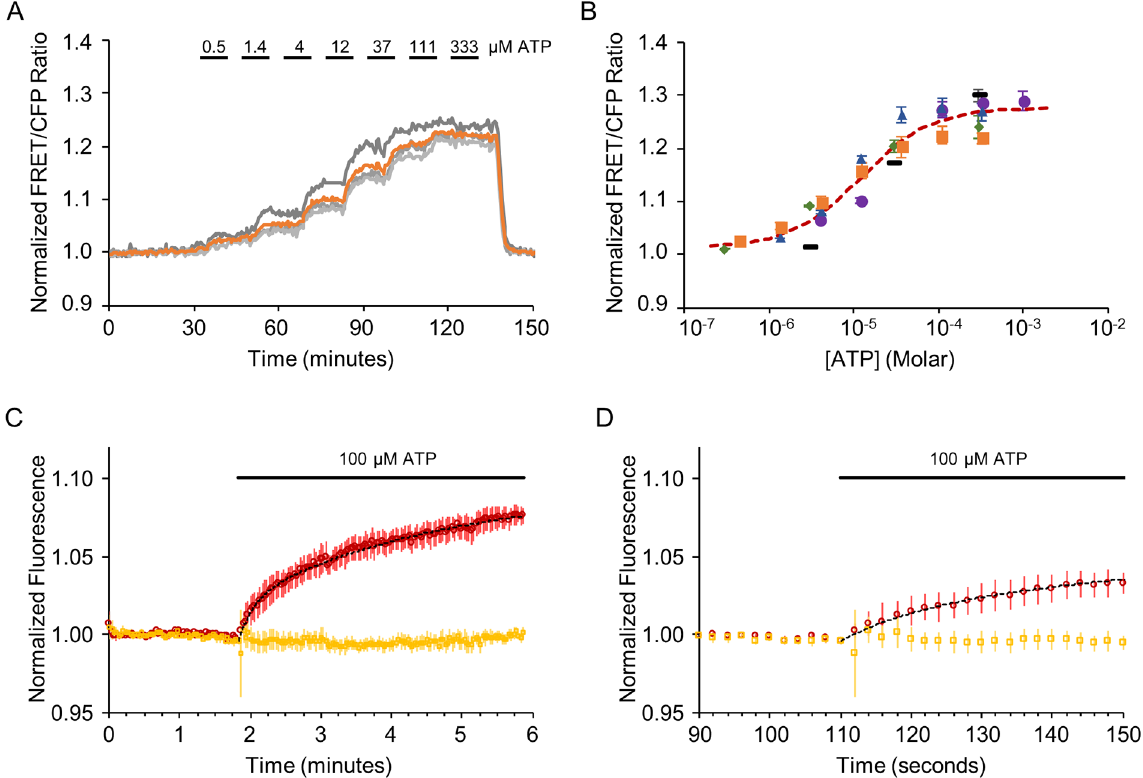
Fig 3. Characterization of ATP affinity and response kinetics. ecATeam3.10 exhibits a concentration-dependent changein FRET/CFP ratio signal.Live Neuro2Acells expressingecAT3.10 were imagedat room temperatureunder continuous perfusion, duringwhich increasing concentrations of extracellular ATP were washed in a stepwise fashion. (A) A representative time course from one experiment with four cells. Each grey trace represents the responsefrom an individual cell in which the regions of interest were drawn aroundthe membrane. The orangetrace is the mean response. (B) Summary of ATP dose-response data from five independent experiments, each representedits own symbols. The orangesquaresrepresent data from (A), and the dashed red curve is fit to the mean of all experiments. In four of the five experiments, sufficient data was availablefor independent fitting to a Hill equation (mean ± sem, n = 4 experiments: K = 12 ± 5 μ M, Ratio max /Ratio min = 1.23 ± 0.01, n = 1.4 ± 0.2). A globalfit of data from all five experiments was also performed for comparison. (fitting mean ± sem, n = 5 experiments: K = 11 ± 2 μ M, Ratio max /Ratio min = 1.28 ± 0.01, n = 0.9 ± 0.1). (C-D) ecAT3.10 responds to an increasein extracellular ATP within seconds. (C) Cells were imagedduring fast perfusionwash in of 100 μ M ATP, and the sensor exhibitedan increasein FRET within seconds (n = 27 cells, 3 experiments; two-exponential fit: τ fast = 13 ± 1 sec, τ slow = 172 ± 18 sec). (D) An expandedview of the initial response shown in (C). Red, FRET fluorescence channelintensity. Yellow,YFP fluorescence channelintensity. Dotted black curve, two-exponential